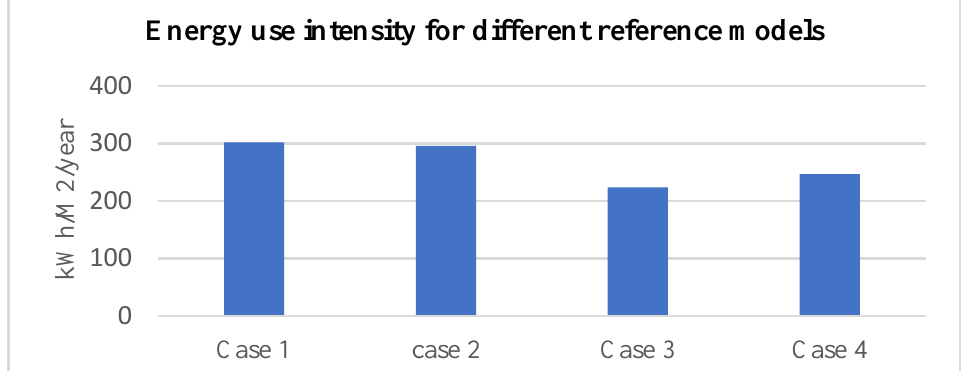
Figure 6. A comparison of the energy end-use and energy-use intensity for different reference cases.